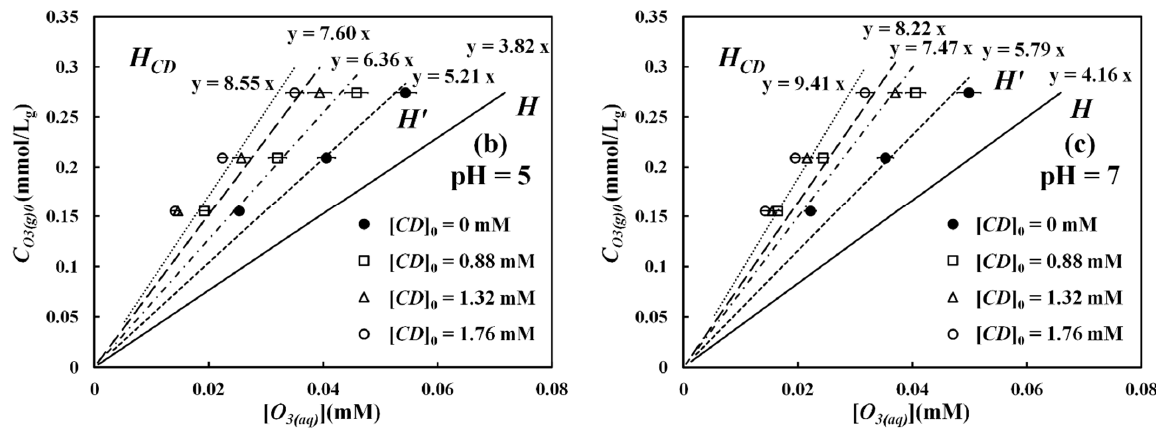
Figure 1. Gaseous ( C O 3 ( g ) 0 ) and aqueous ( ) ozone concentration relationships in dynamic equilibrium in the O 3 - β CD system under three different pH values: ( a ) pH = 3; ( b ) pH = 5; ( c ) pH = 7.